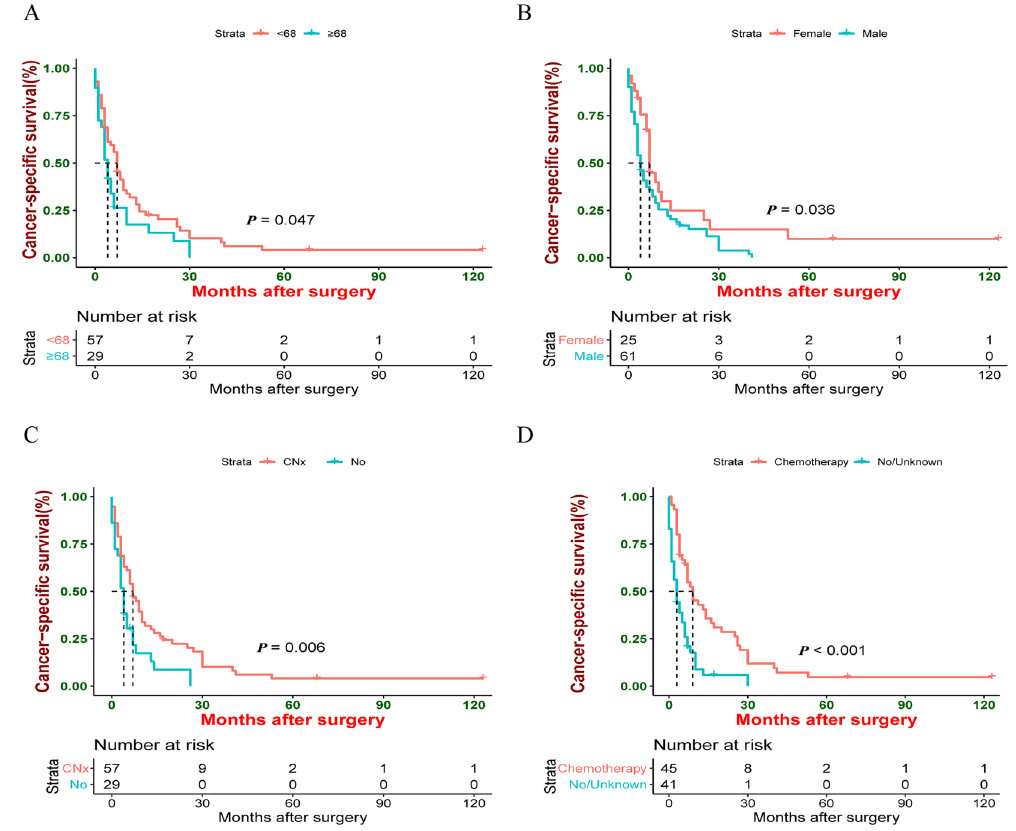
Figure 2. Kaplan–Meier estimate of Cancer-specific survival (CSS) by ( A ) Age, ( B ) Sex, ( C ) CNx, ( D )